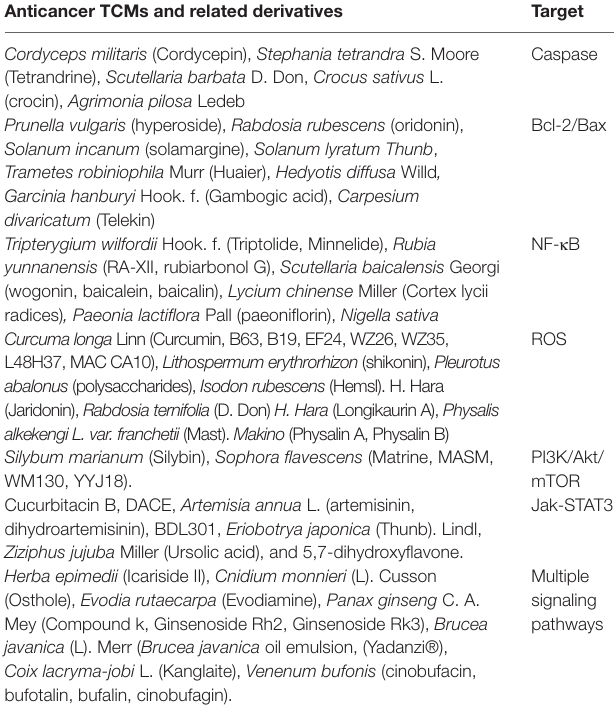
TABLE 1 | Summary of the therapeutic targets for anticancer traditional Chinese medicines (TCMs) and related derivatives in cellular apoptotic